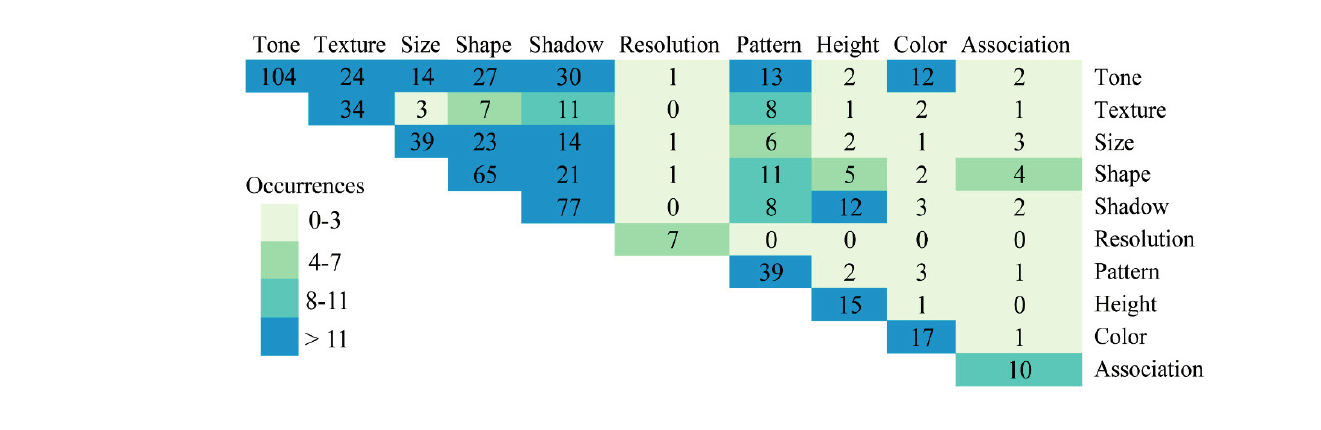
Figure 3. The co-occurrence of Interpretation Element